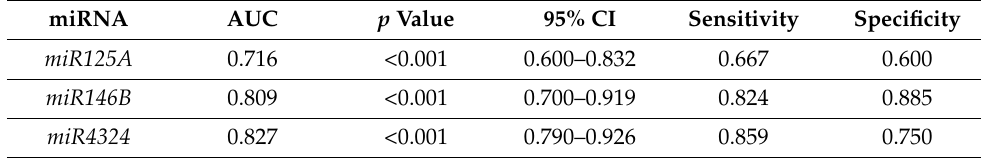
Table 5. Prognostic value of miRNAs in differentiating malignant from benign nodules. miRNA AUC p Value 95% CI Sensitivity Specificity miR125A 0.716 <0.001 0.600–0.832 0.667 0.600 miR146B 0.809 <0.001 0.700–0.919 0.824 0.885 miR4324 0.827 <0.001 0.790–0.926 0.859